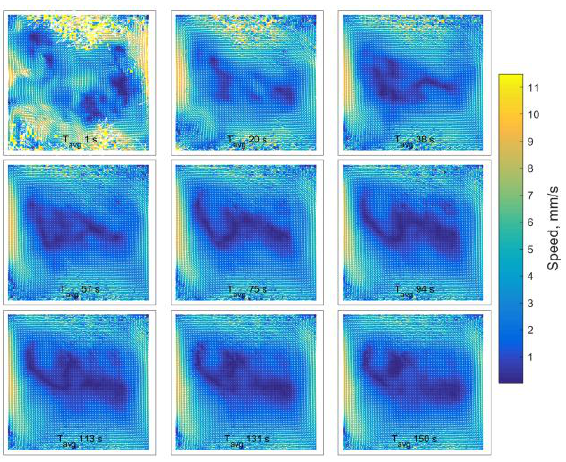
Fig. 4. Velocity fields for a set of 9 different averaging times from 1 to 150 seconds